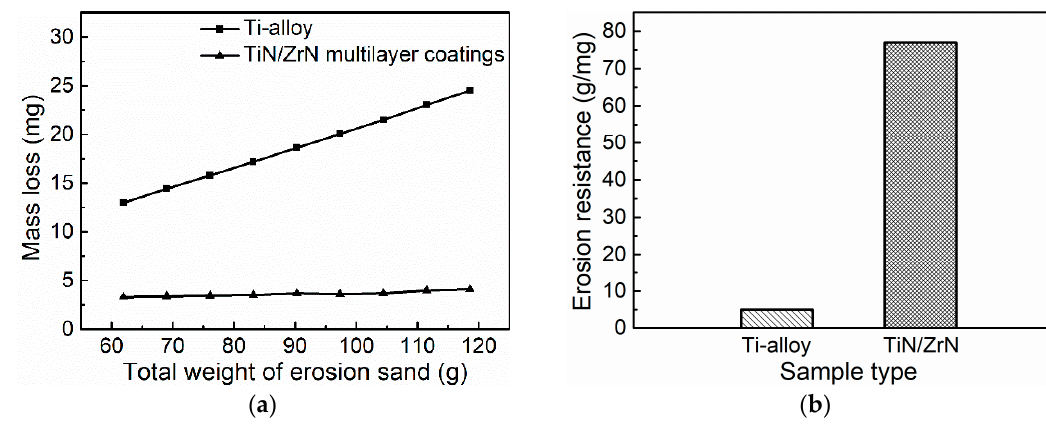
Figure 5. Mass loss and erosion resistance of the uncoated Ti alloy sample and the TiN/ZrN-coated sample.